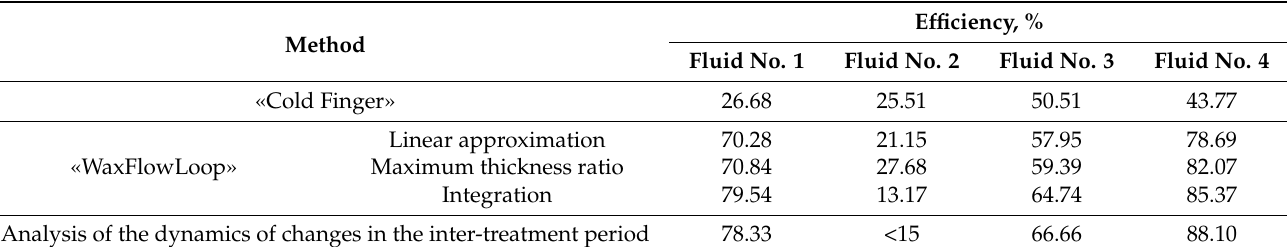
Table 2. Results of calculating the effectiveness of the inhibitor reagent in laboratory and field